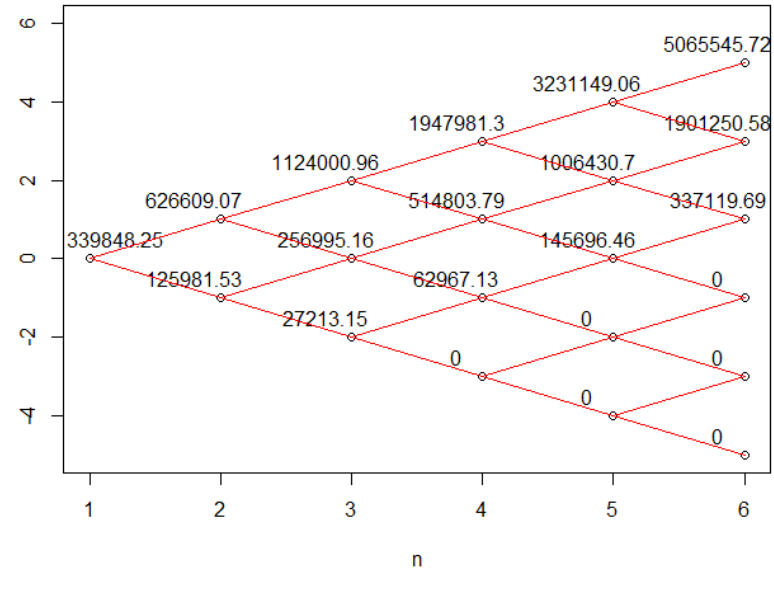
Figure 8. Tree 2 option to wait without